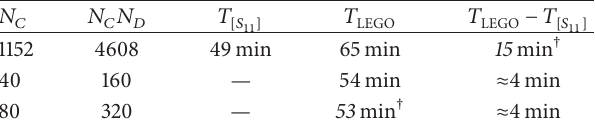
Figure 10: Microplasma rods: eigenvalues of [𝑆 11 ] , as a function of their index 𝑝 = 1,...,2𝑁 𝐹 relative to the brick of the model in Figure 8 for three frequency values. Inset: closeup of the spectrum showing trend as frequency is increased. Table 2: Computation times for the problem of Figure 5.